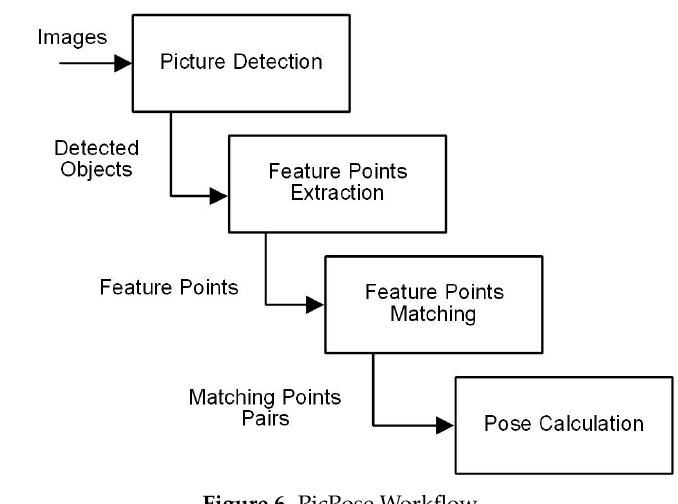
Figure 6. PicPose